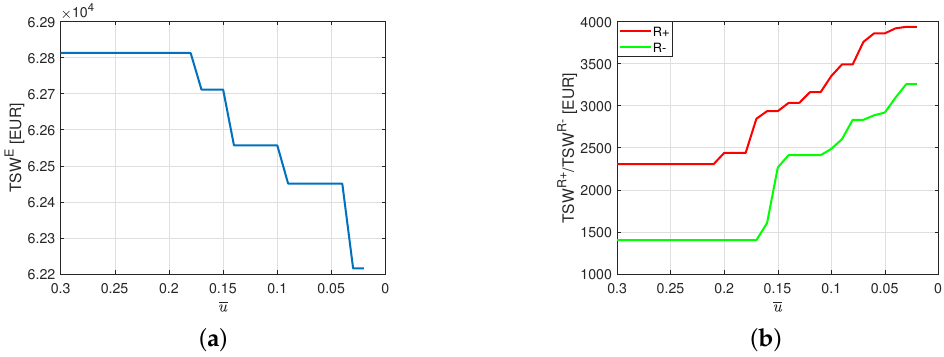
Figure 2. ( a ) Total social welfare of the energy sub-market ( TSW E ) as the parameter u is decreased. ( b ) Total social welfare of the reserve sub-markets as the parameter u is decreased. TSW R + and TSW R − denote the total social welfare of the positive and the negative reserve market respectively